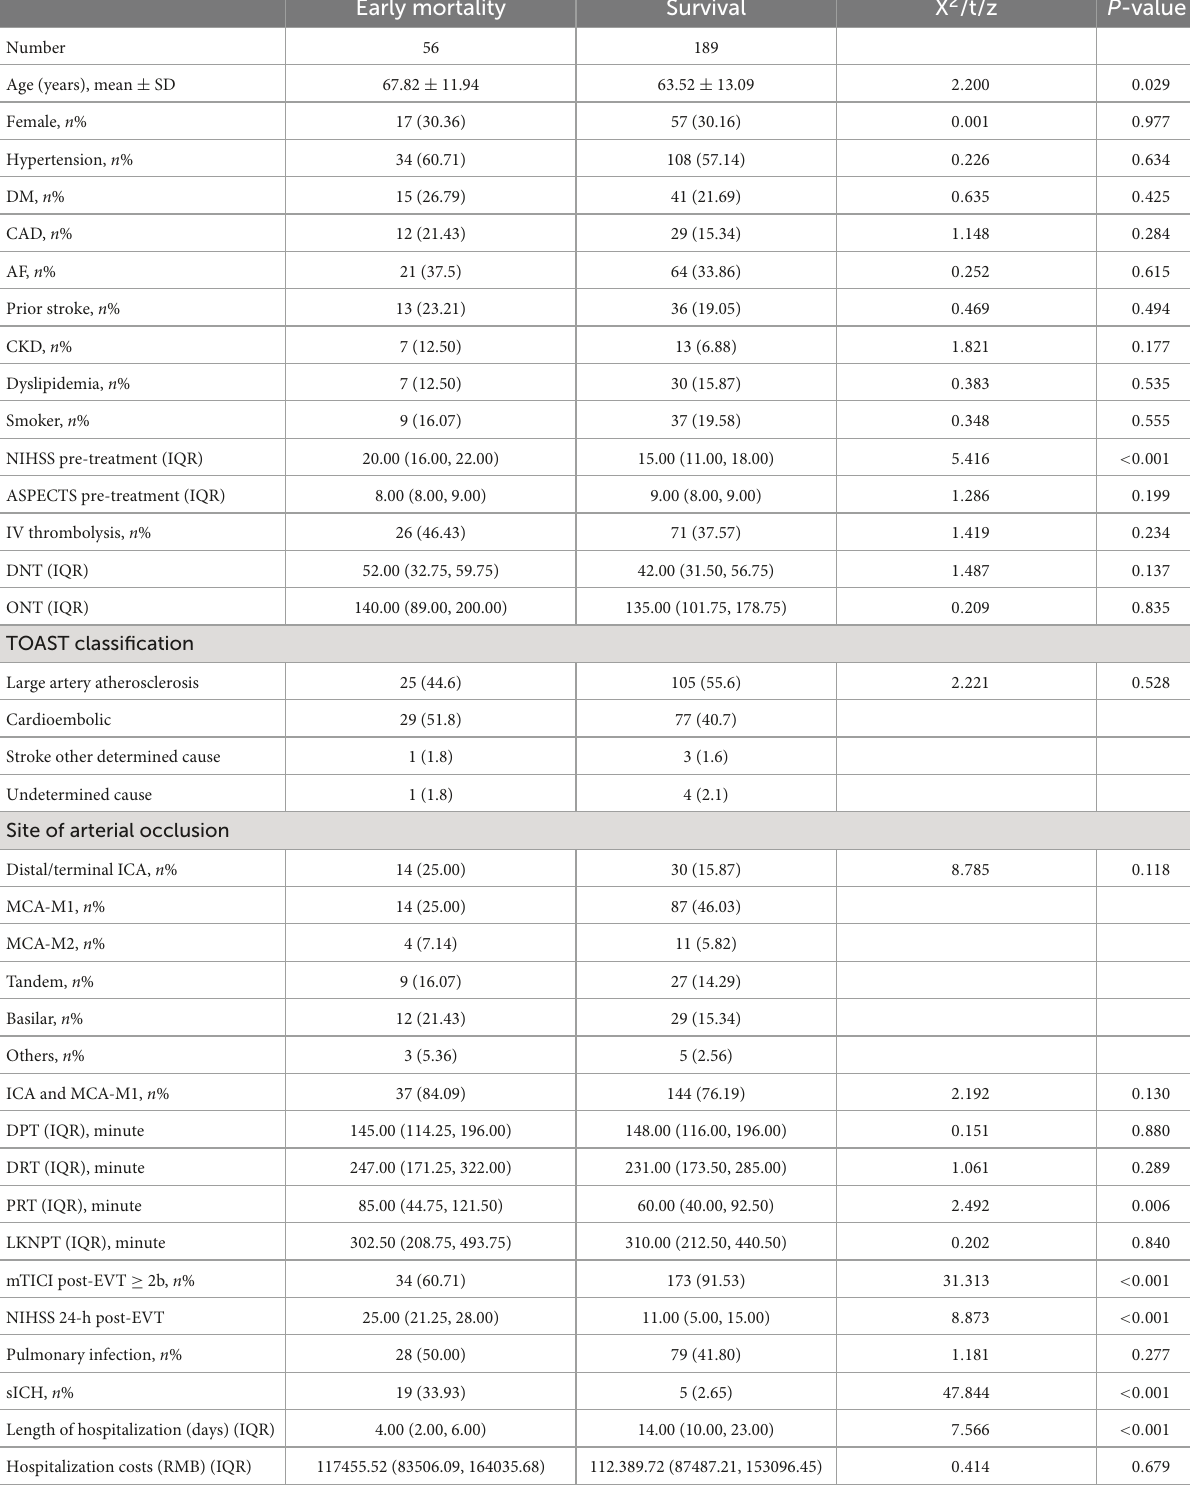
TABLE 1 Summary of demographic, clinical hemodynamic, and therapeutic features between non-surviving and surviving